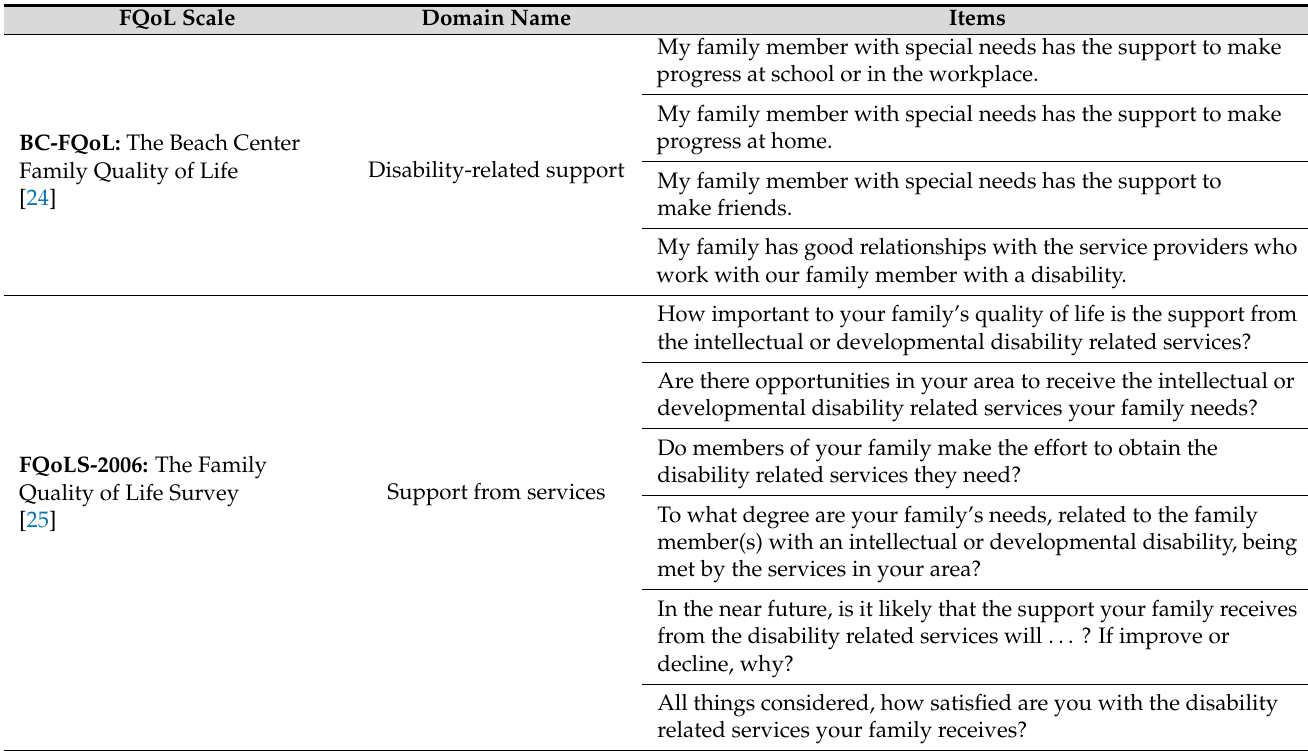
Table 7. Items considered in the domain of disability support within each FQoL scale.